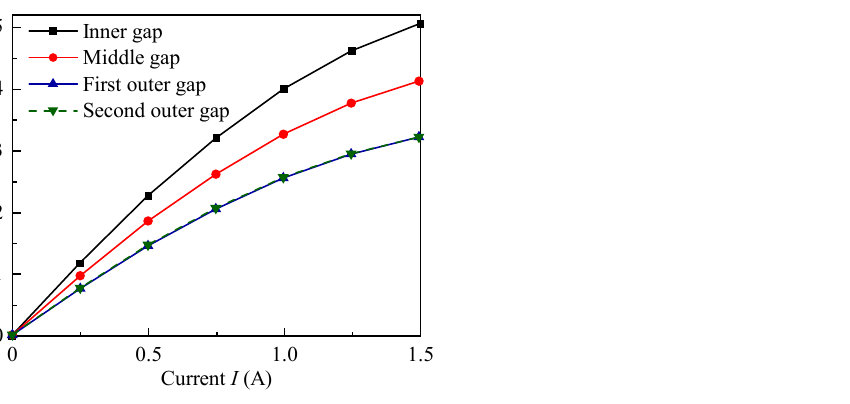
Figure 12. Average magnetic flux density of the optimal MR damper along the detected damping gap with various current inputs.